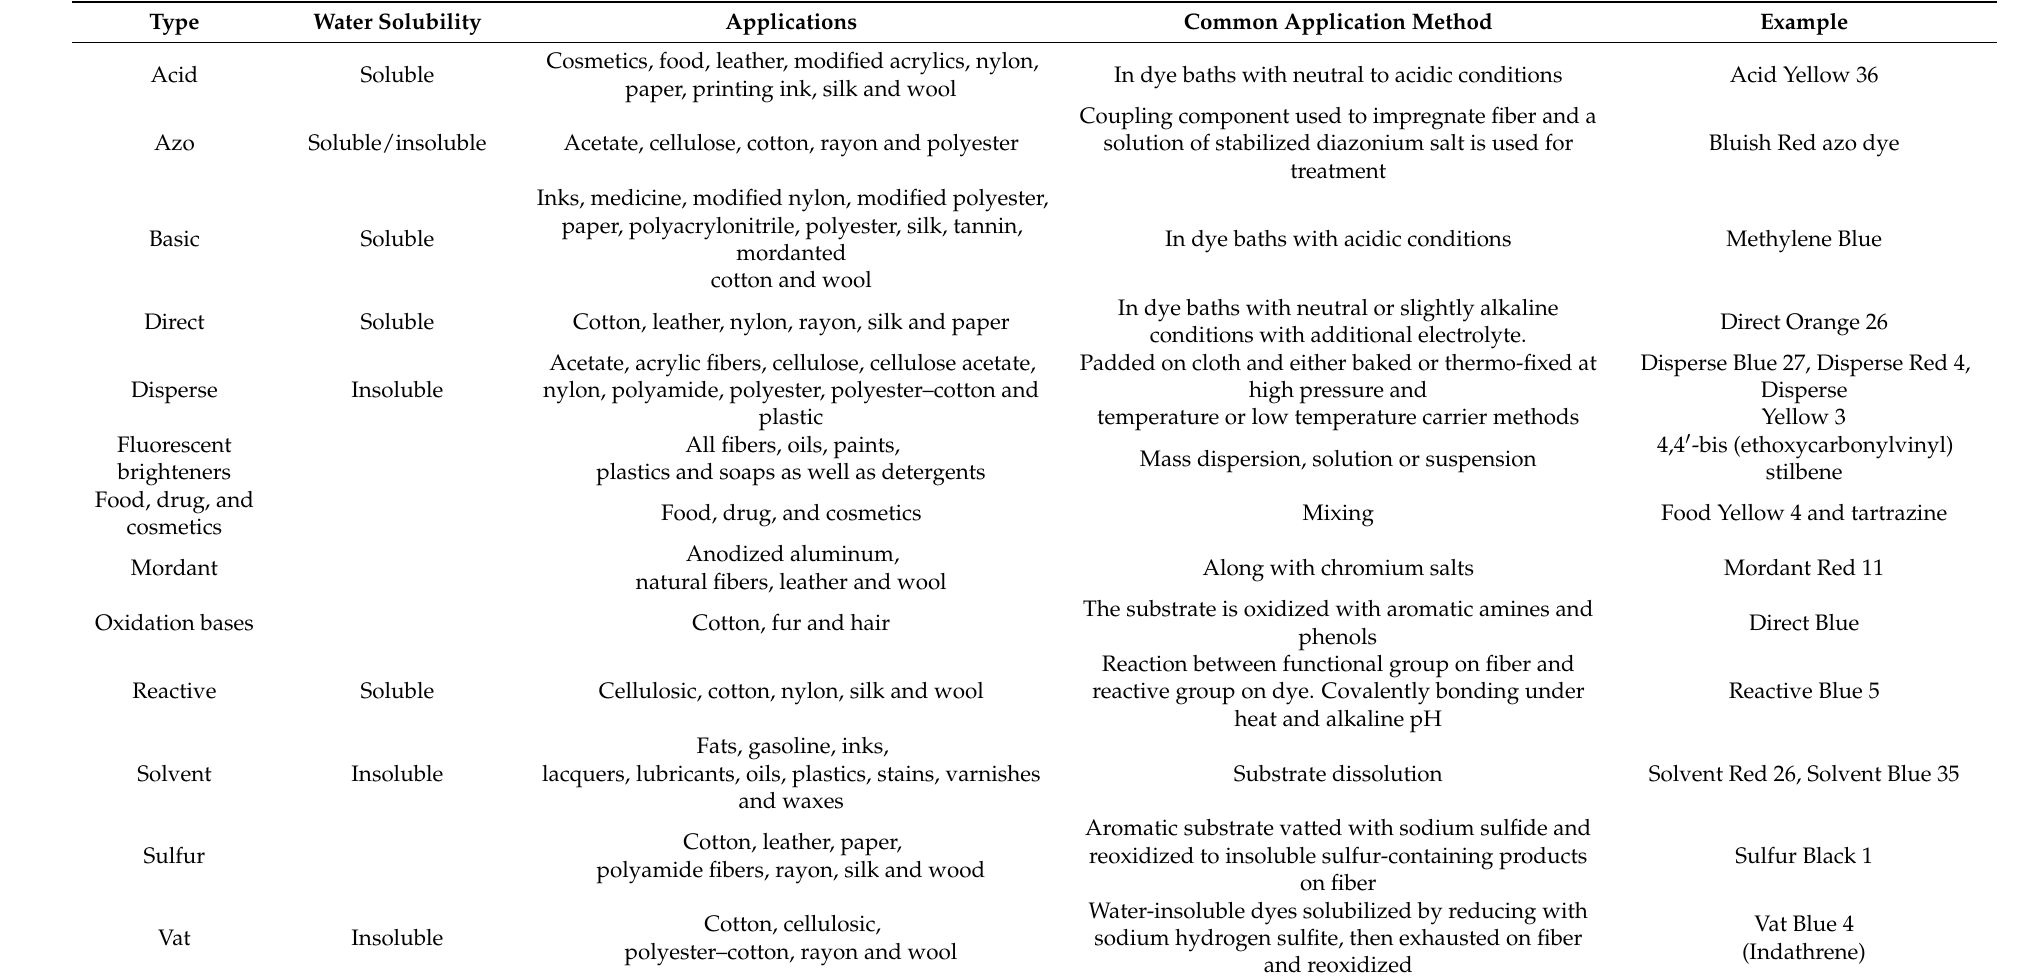
Table 1. Different types of dyes and their main applications. (Adapted from reference [8], Copyright 2018